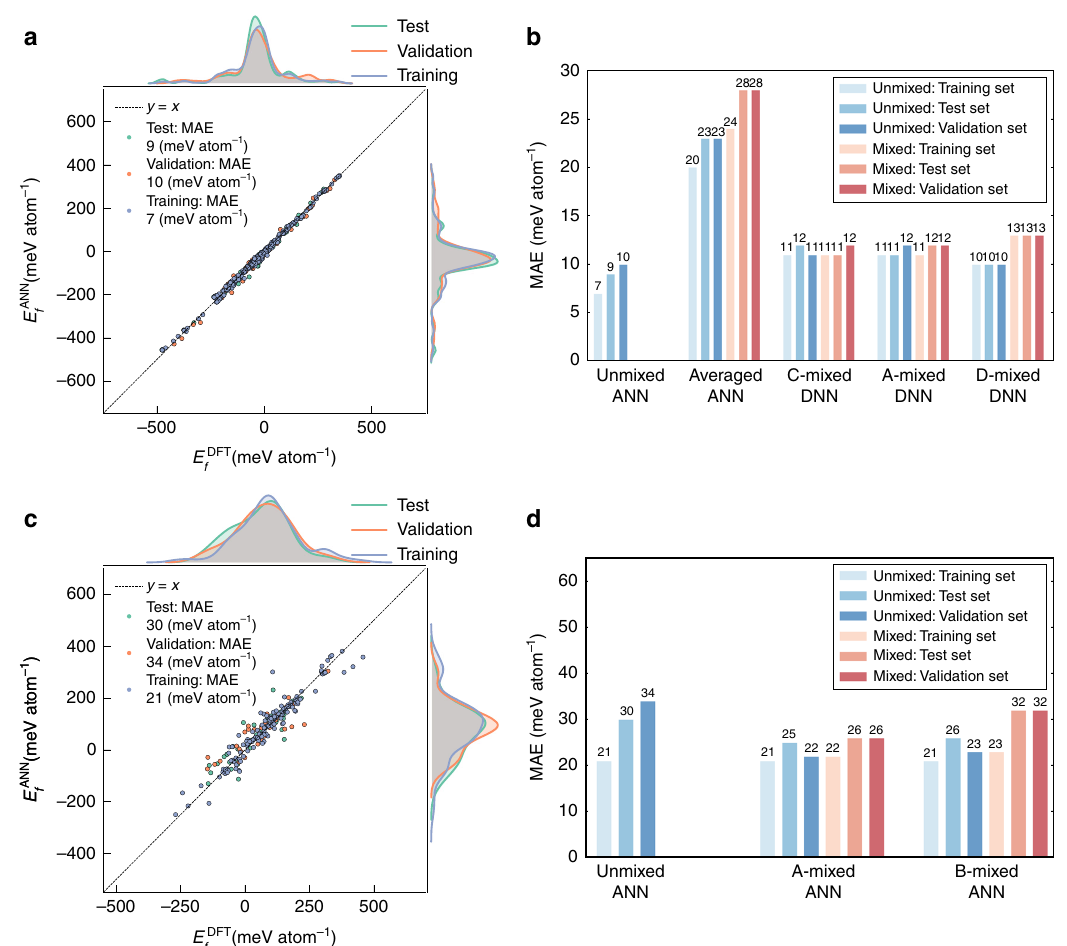
Fig. 3 Performance of arti fi cial neural network (ANN) models. a Plot of E ANN f against E DFT f of unmixed garnets for optimized 6-24-1 ANN model. The histograms at the top and right show that the training, validation and test sets contain a good spread of data across the entire energy range of interest with standard deviations of 122 – 134 meV atom − 1 . Low mean absolute errors (MAEs) in E f of 7, 10, and 9 meV atom − 1 are observed for the training, validation, and test sets, respectively. b MAEs in E f of unmixed and mixed samples in training, validation, and test sets of all garnet models. The C-, A- and D-mixed deep neural networks (DNNs) have similar MAEs as the unmixed ANN model, indicating that the neural network has learned the effect of orderings on E f . Each C-, A- and D-mixed composition has 20, 18, and 7 distinct orderings, respectively, which are encoded using 5-bit, 5-bit, and 3-bit binary arrays, respectively. c MAEs in E f of unmixed and mixed samples for training, validation and test sets of unmixed perovskites for 4-12-1 ANN model. The E DFT f of training, validation, and test sets similarly contain a good spread of data across the entire energy range of interest with standard deviations of 104 – 122 meV atom − 1 . Low mean absolute errors (MAEs) in E f of 21, 34, and 30 meV atom − 1 are observed for the training, validation, and test sets, respectively. d MAEs in E f for training, validation, and test sets of all perovskite models. Each A- and B- mixed perovskite compositions has ten distinct orderings, which are both encoded using 4-bit binary arrays. The black lines (dashed) in ( a , c ) are the identity lines serving as